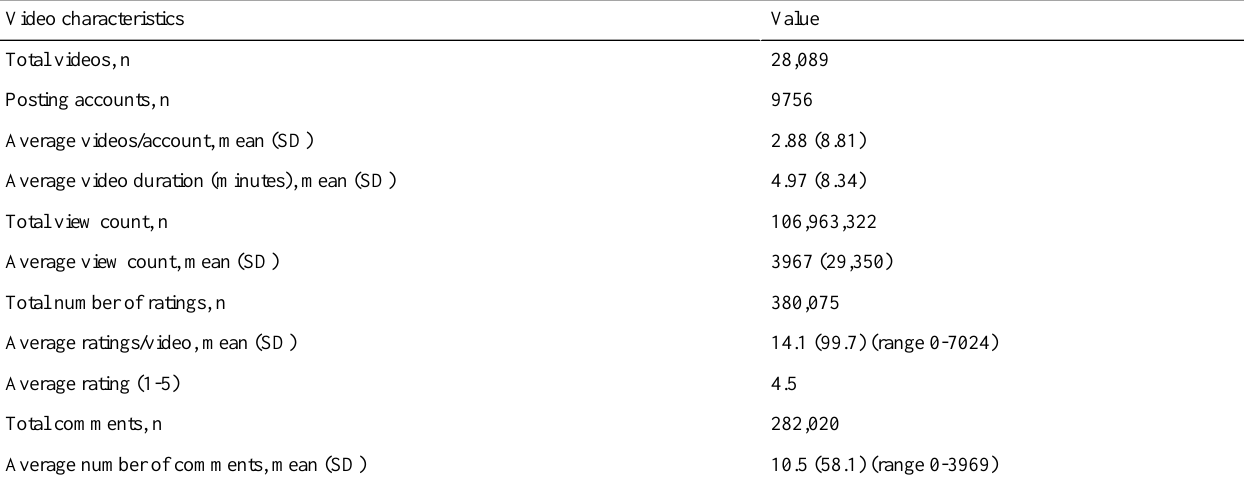
Table 1. Characteristics of e-cigarette-related YouTube videos as of June 30, 2013.